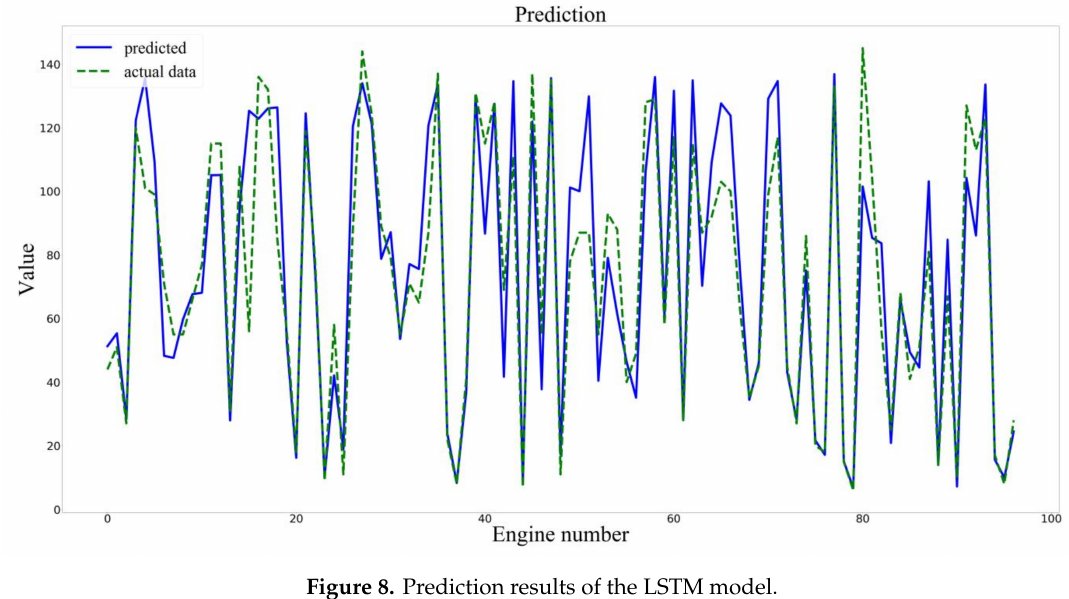
Figure 8. Prediction results of the LSTM model.